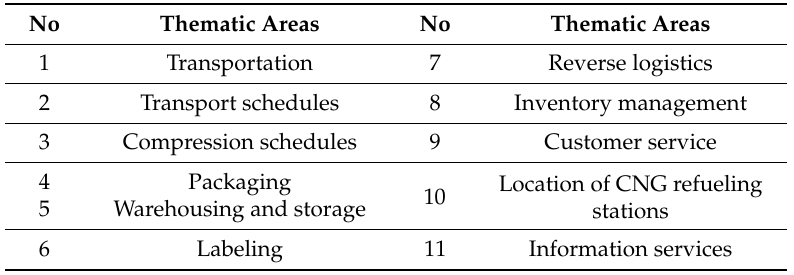
Table 2. Thematic areas of conducting a semi-structures interview.